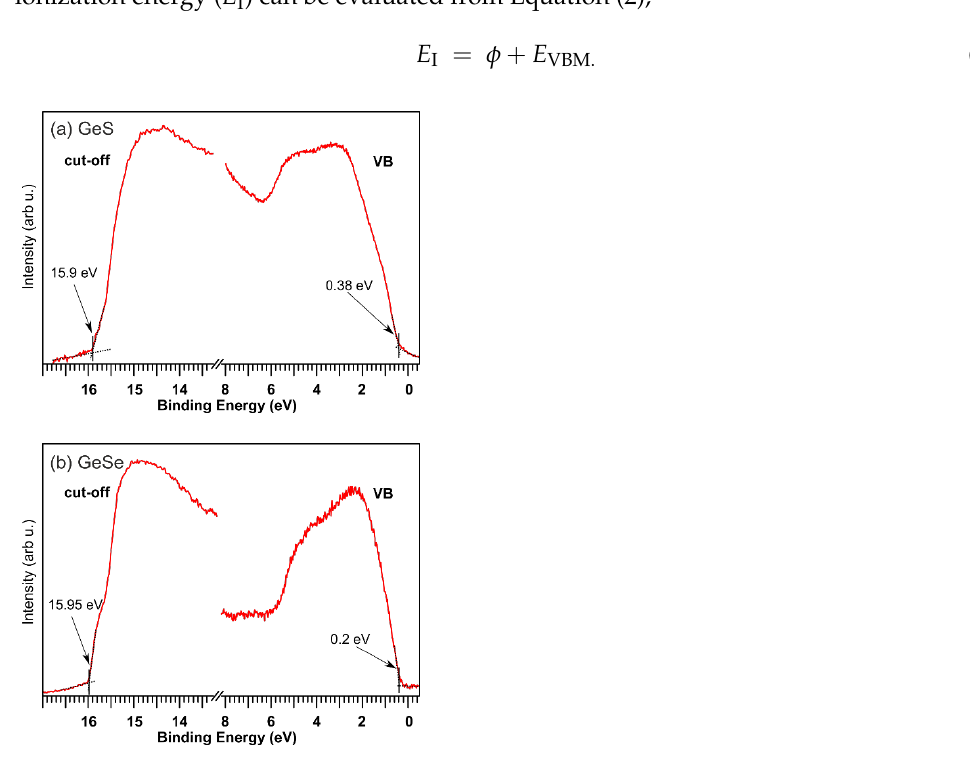
Figure 4. UPS spectra of ( a ) GeS and ( b ) GeSe measured using He I photons ( hv = 21.22 eV). The secondary electron cut-off energy ( E cutoff ) and valence band maximum position ( E VBM ) are labelled in the figure.